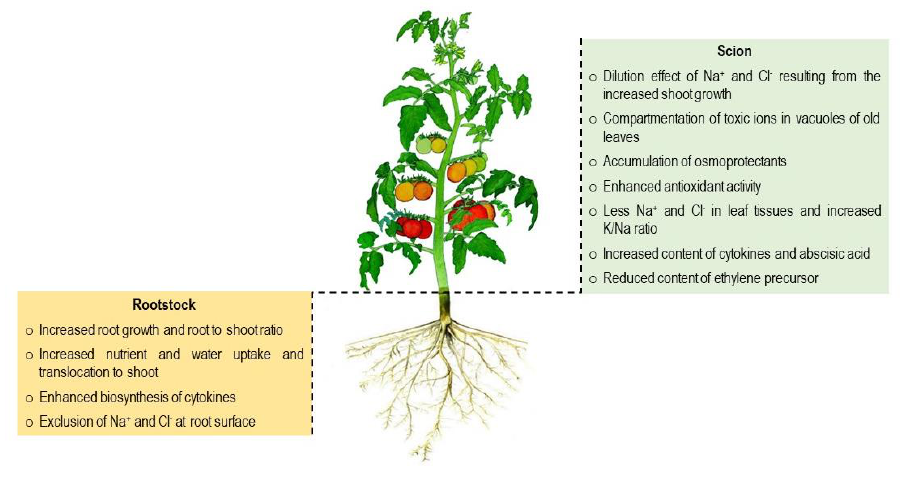
Figure 1. Physiological adaptive traits to mitigate the effect of salt stress in grafted plants.